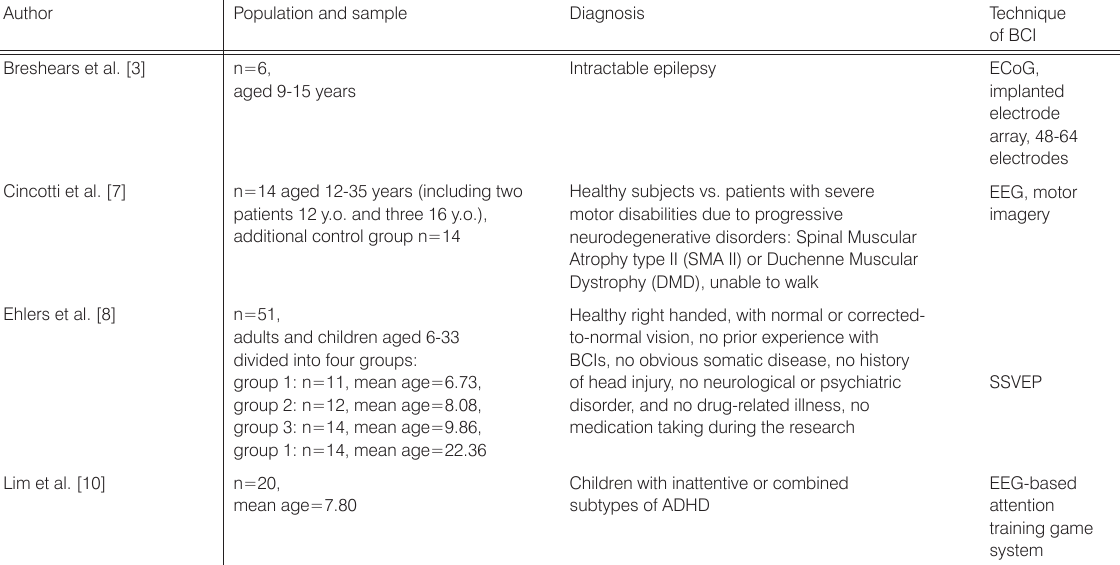
Table 1. Available data from the literature concerning BCIs’ application in